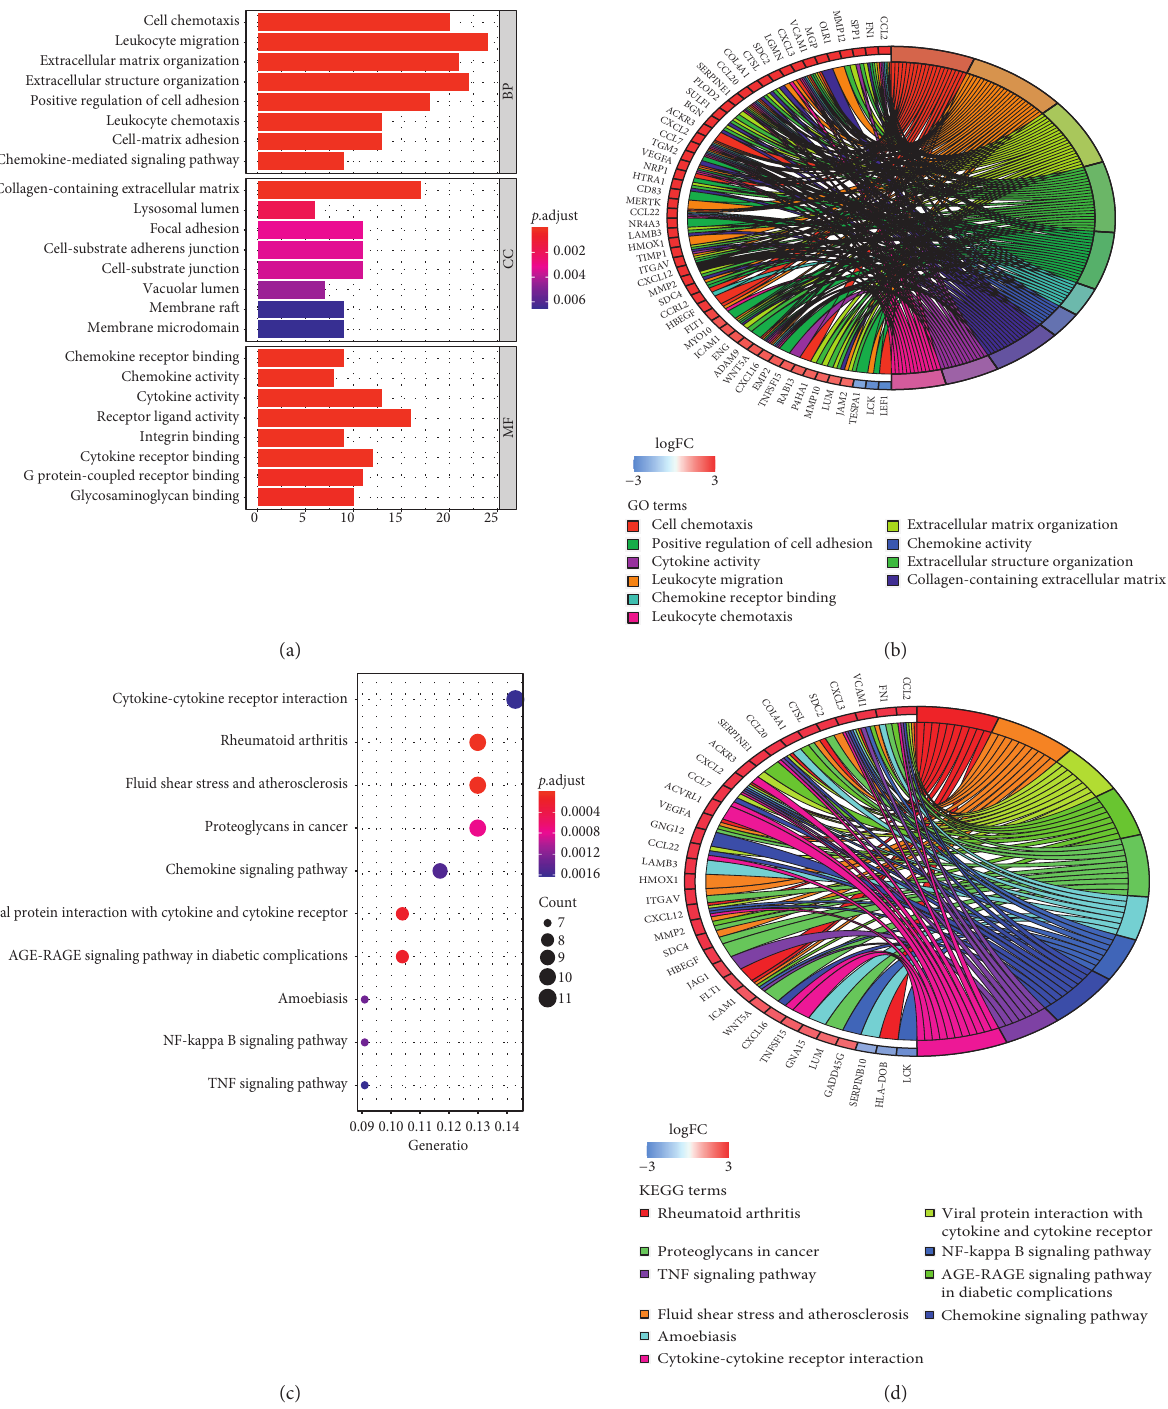
Figure 2: (a) Top 8 items of BP, CC, and MF shown in the bar chart according to adjust p value. (b) GO chord plot and the order of genes arranged by logFC. (c, d) KEGG pathways enriched by DEGs presented by bubble plot and chord plot, respectively. BP, biological process; CC, cellular component; MF, molecular function; GO, Gene Ontology; logFC, log2 fold change; KEGG, Kyoto Encyclopedia of Genes and